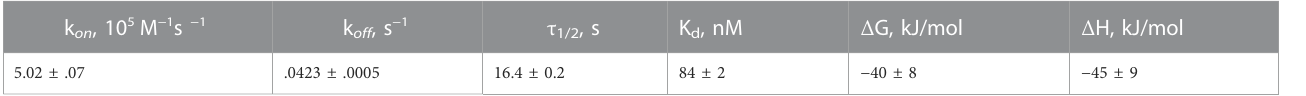
TABLE 1 Kinetic and thermodynamic parameters of the complex formation between FdxE and